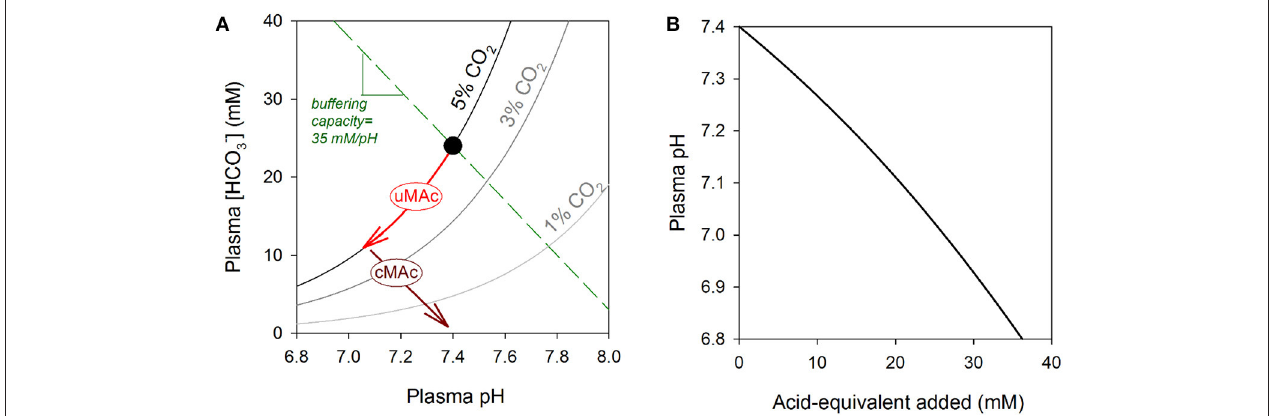
FIGURE 1 | (A) Davenport diagram. Relationship between plasma pH and plasma [HCO − 3 ] shown for three CO 2 isobars, including 5% (physiological) and two levels associated with hyperventilation (3 and 1%). Normal acid-base balance is represented by the black dot. A metabolic acidosis will result in a decrease in [HCO − 3 ]; if this is associated with a fall in pH, it is known as an uncompensated metabolic acidosis (uMAc) and its trajectory is along the 5% CO 2 isobar. This metabolic acidosis can be compensated (cMAc) by hyperventilation to reduce CO 2 and thus restore the [HCO − 3 ]/CO 2 ratio to a level that is closer to pH 7.4. The direction of change will be parallel to the buffering capacity line, which is defined by the sum of all non-CO 2 /HCO − 3 buffers. For normal hematocrit, the buffering line has a slope close to 35 mM/pH. (B) Effect of adding non-volatile acid-equivalents on plasma pH. The gradient of this relationship is defined by carbonic and non-carbonic buffers. During a metabolic acidosis, even small changes in pH can be related to major disturbances in the levels of organic anions, the conjugate bases of metabolic acids. Change in pH was calculated as amount of acid added divided by buffering capacity. Buffering capacity due to non-carbonic sources was 35 mM/pH, and attributable mainly to hemoglobin in red cells. Buffering capacity due to CO 2 /HCO − 3 was calculated assuming constancy of CO 2 at 5% (i.e., 2.303 × [HCO − 3 ]), as expected for an open system. The calculation assumes a 0.2 pH gradient between plasma and red blood cell cytoplasm, and a hematocrit of